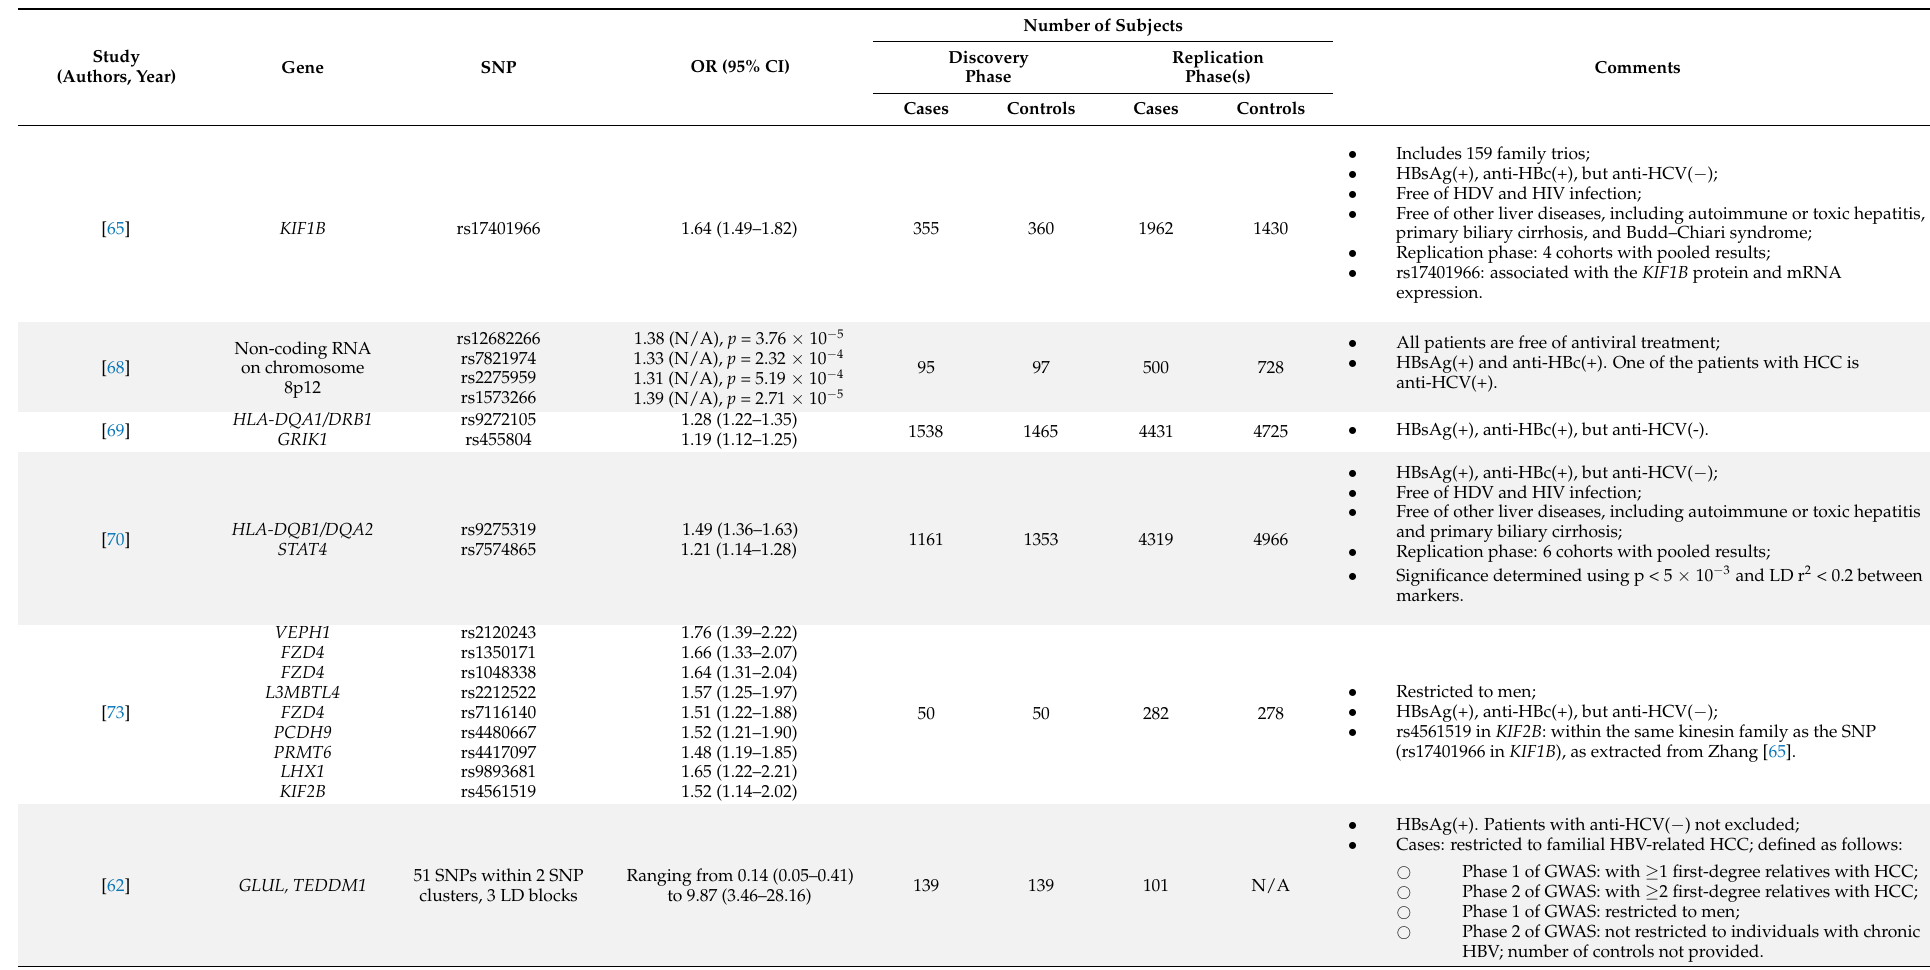
Table 2. GWASs of HBV-Related HCC